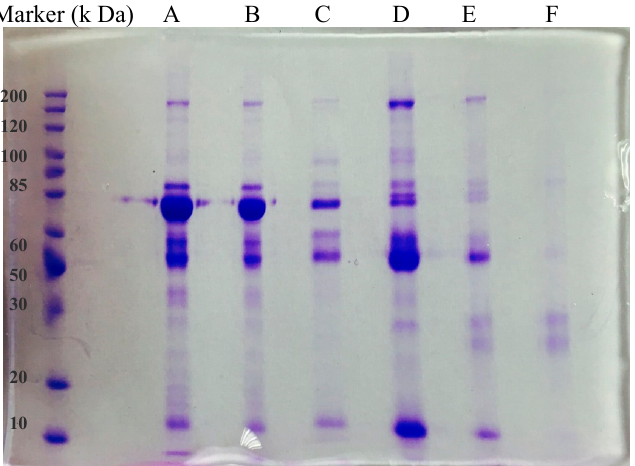
Figure 9. SDS-PAGE of serum eluates from different columns. (A) Diluted original serum; (B) NIP, (C–F) MIP C–F (in Table 1).